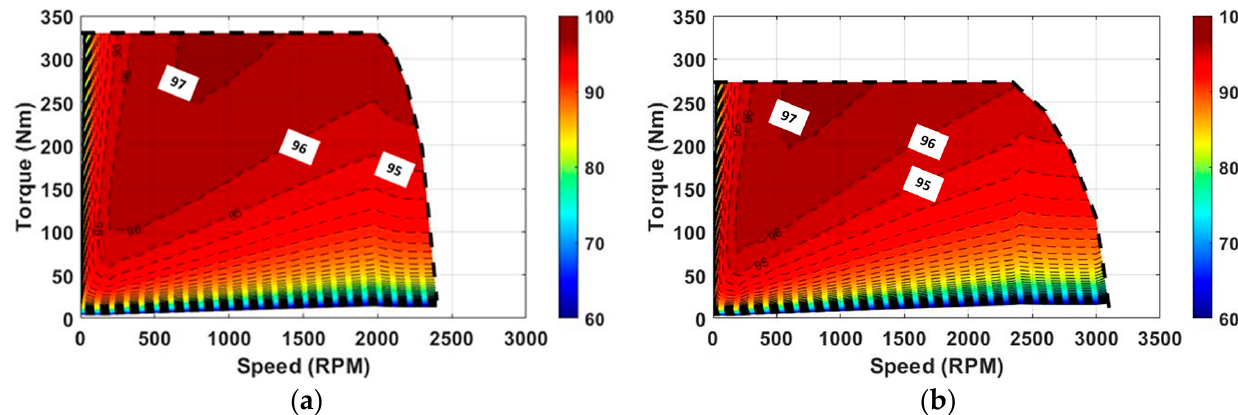
Figure 4. Efficiency maps of ( a ) modular machine and ( b ) non-modular machine. Table 1. General parameters of the investigated SPM machines.